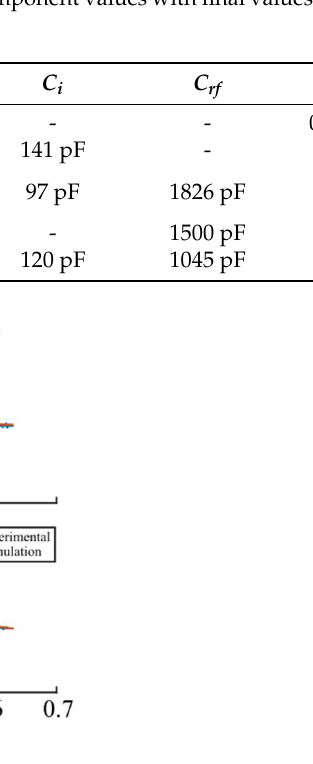
Figure 9. Experimental and PSpice simulation waveforms for a 20 V, 1150 mA discharge.